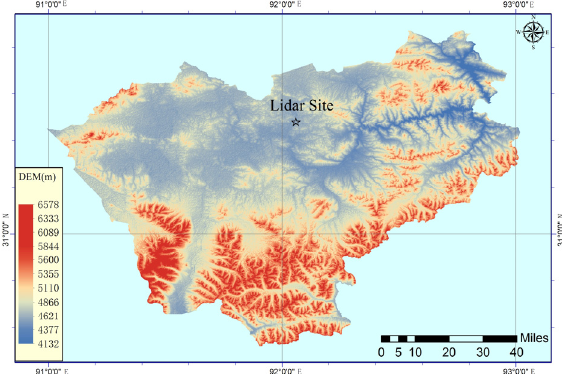
Figure 1. Location of the experimental observation site and the topography of the Tibetan Plateau (DEM: Digital Elevation Model).